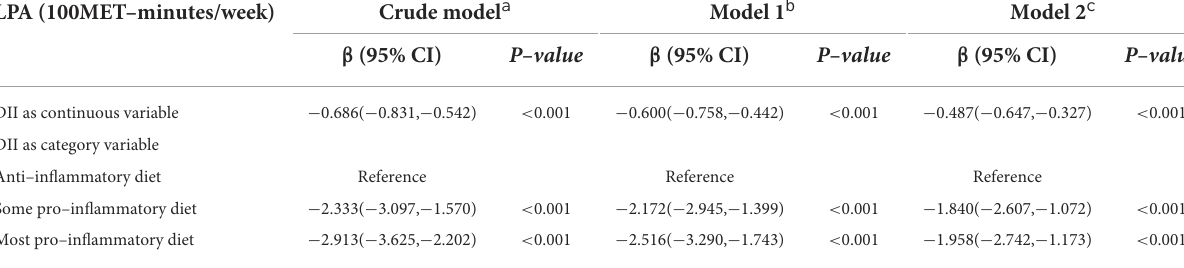
TABLE 2 Associations between leisure–time physical activity and dietary inflammatory index.